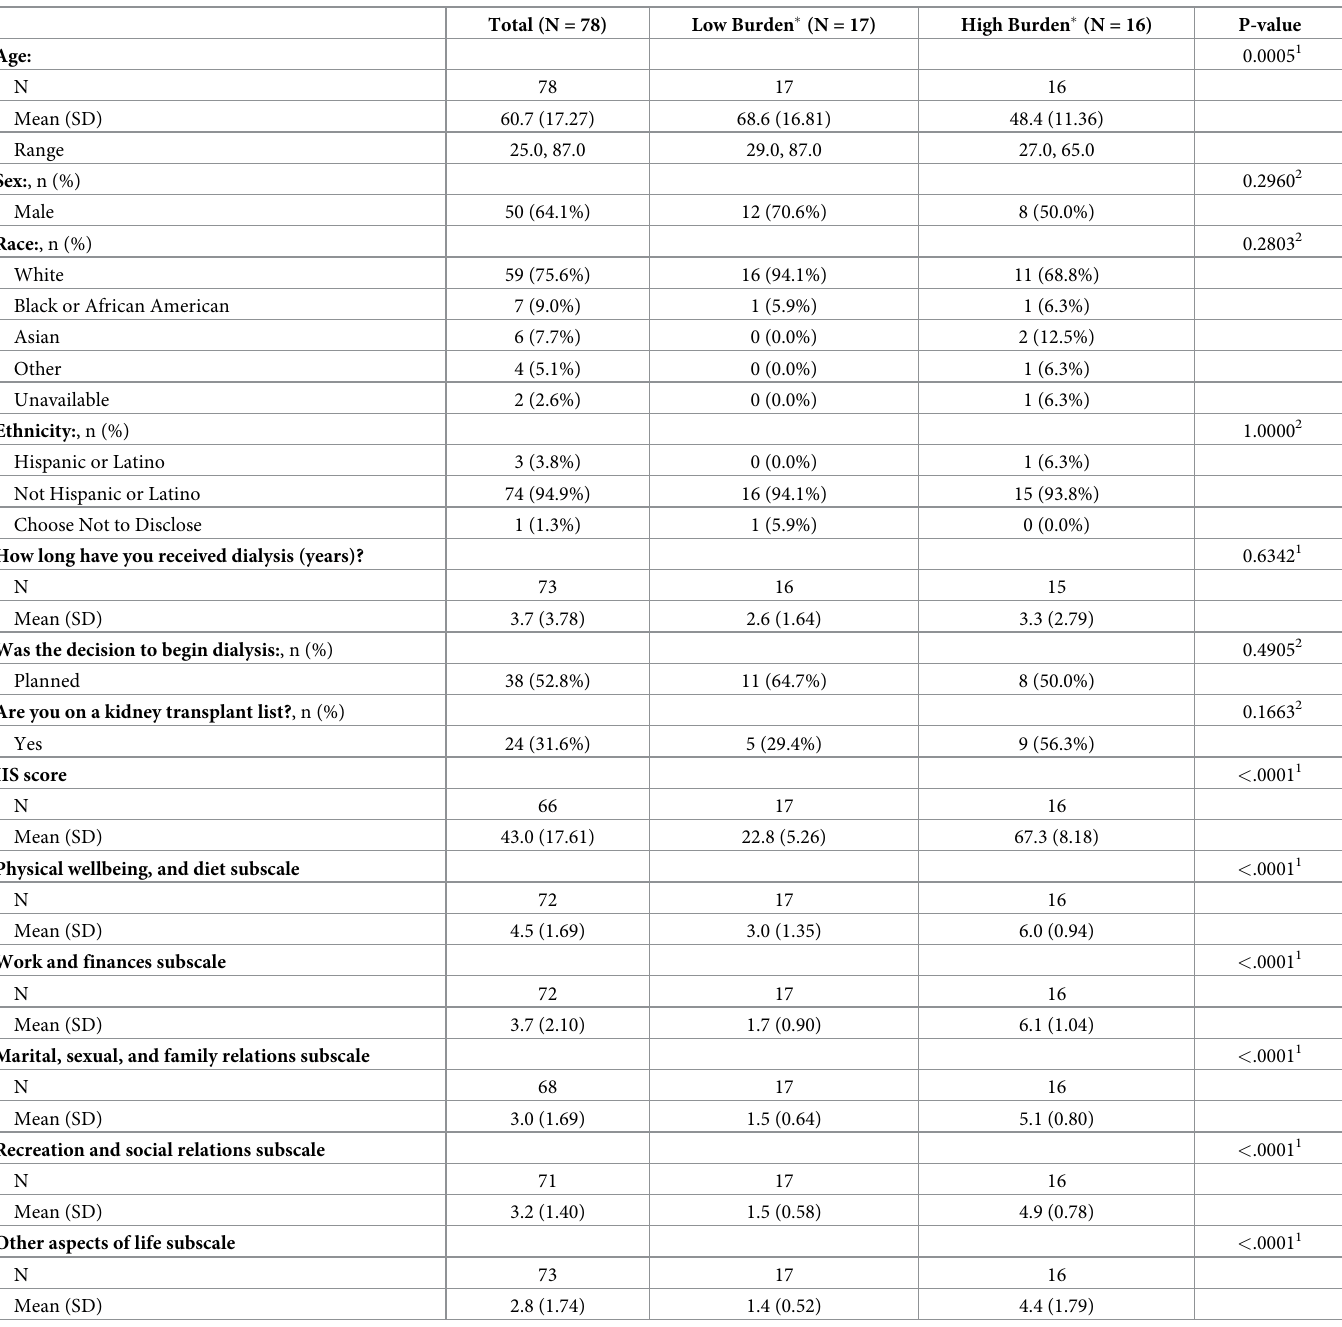
Table 1. Patient demographic characteristics by patients reporting high versus low